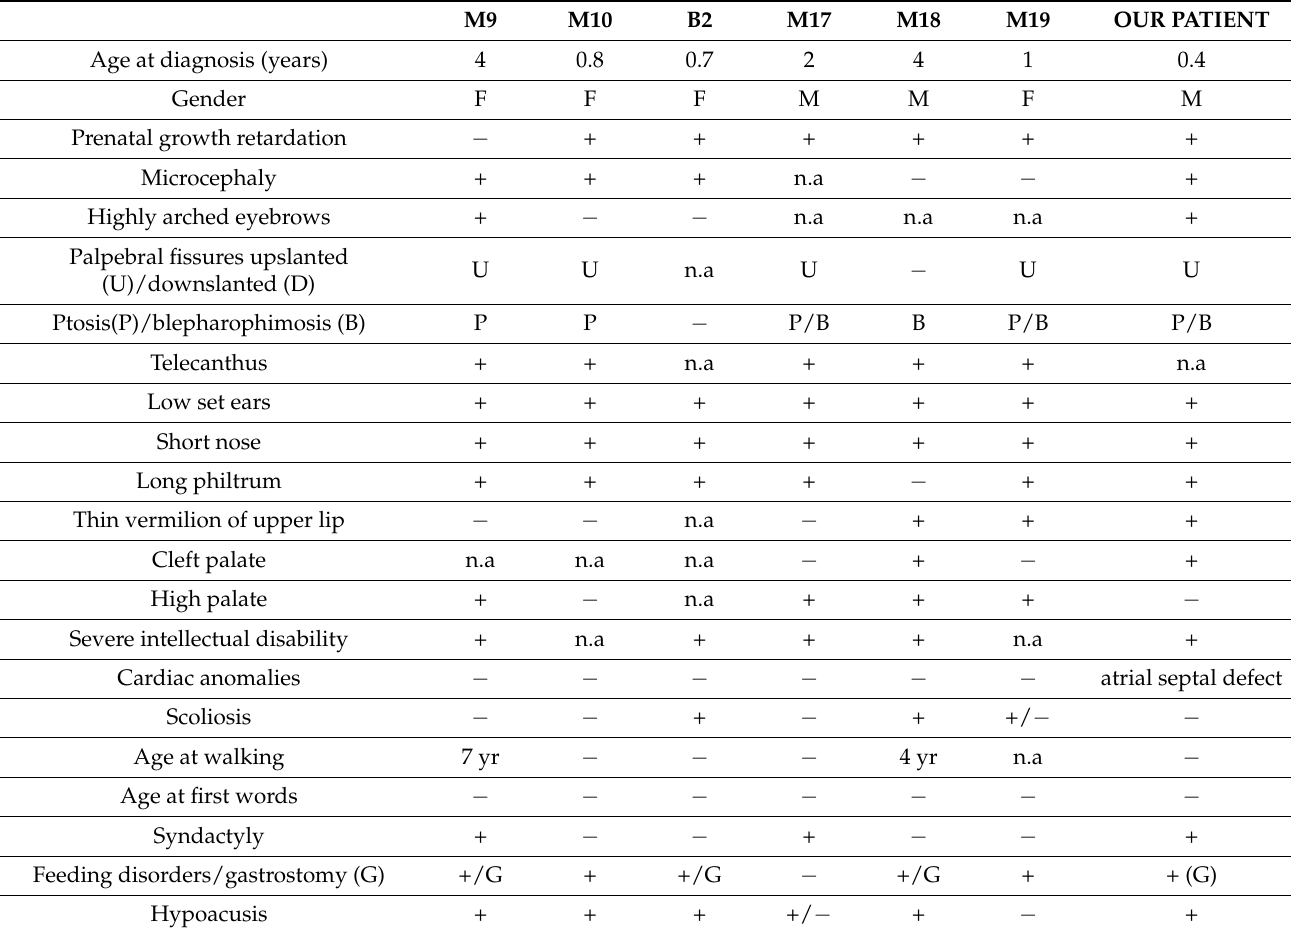
Table 3. Clinical features of the seven patients with the same CREBBP gene variant (c.5602C >